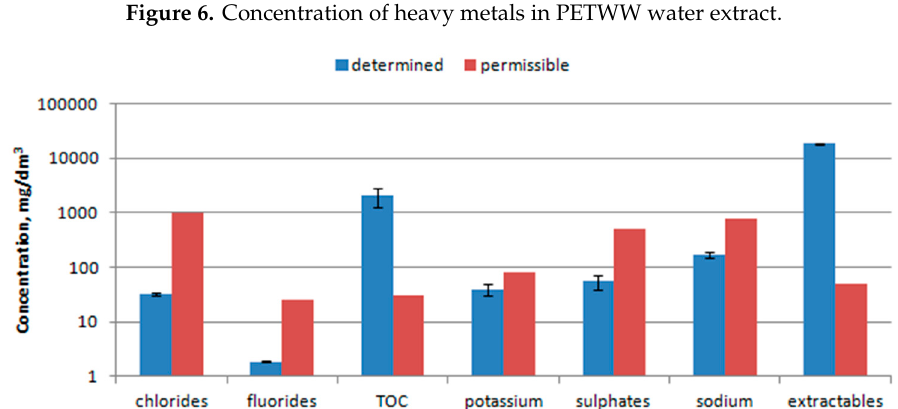
Figure 7. Concentration of ingredients in PETWW water extract.